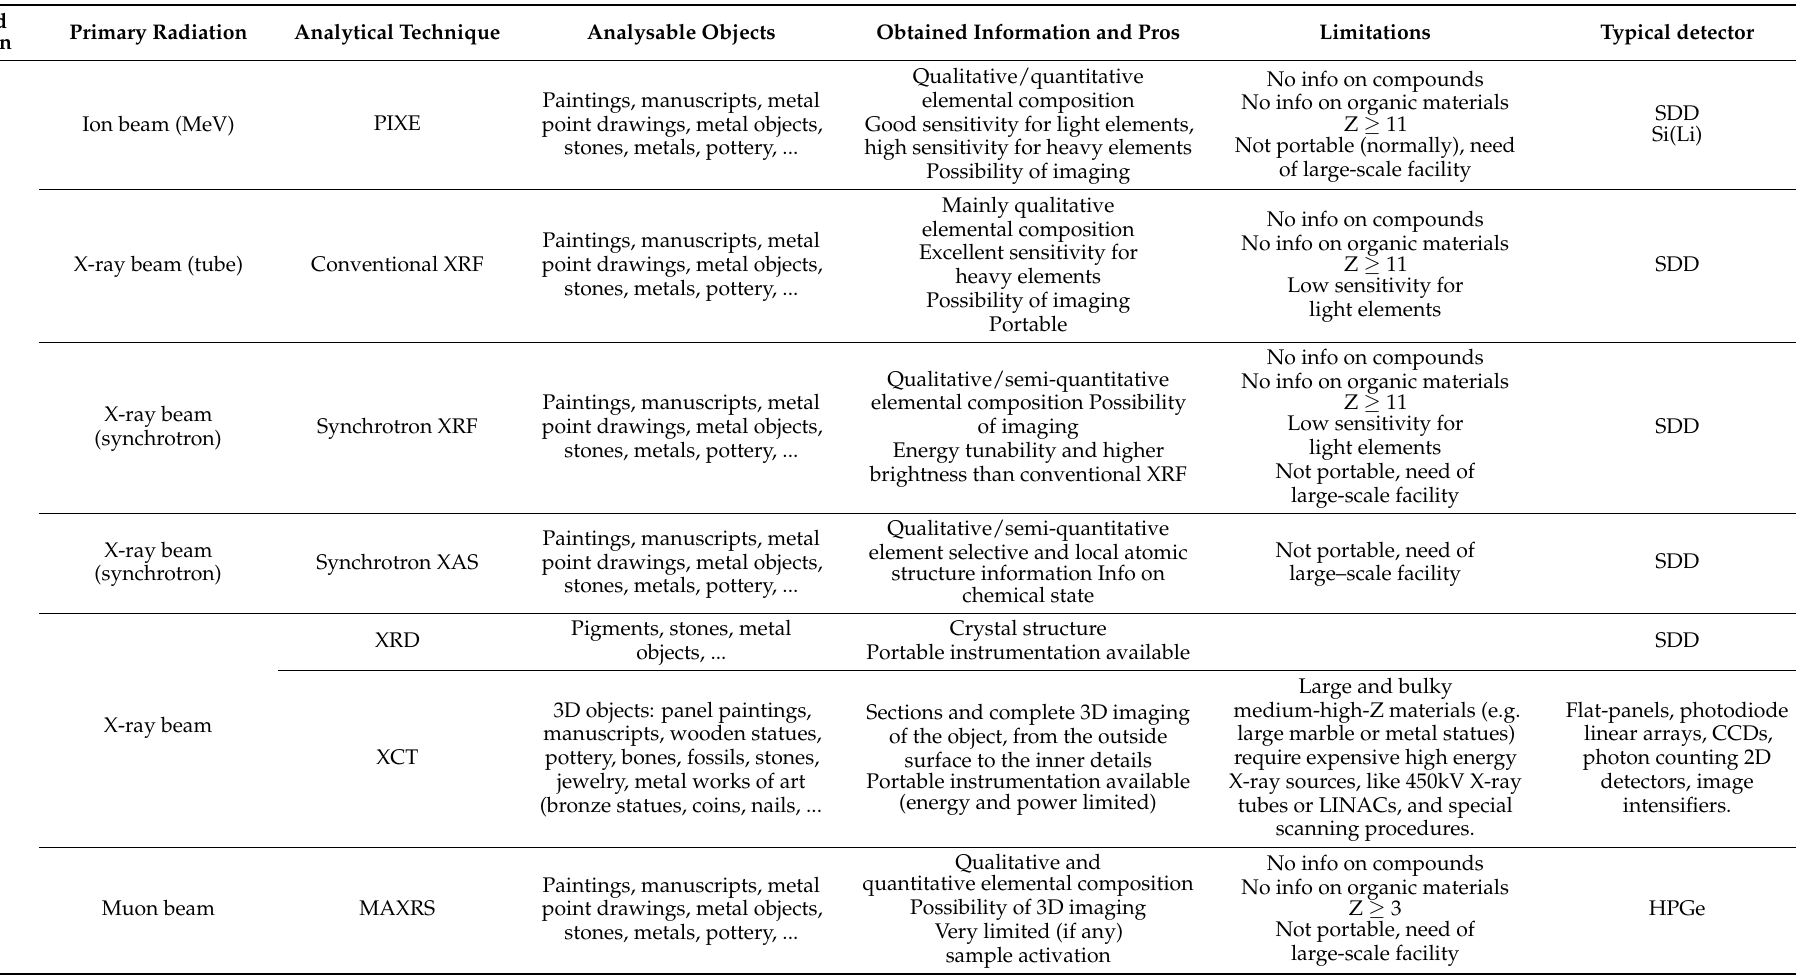
Table A1. Summary of techniques presented in the paper along with obtained